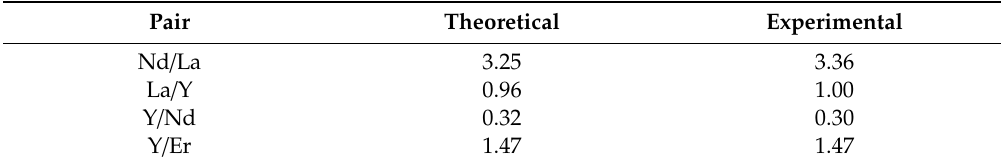
(cid:112) K Sp β 1 .